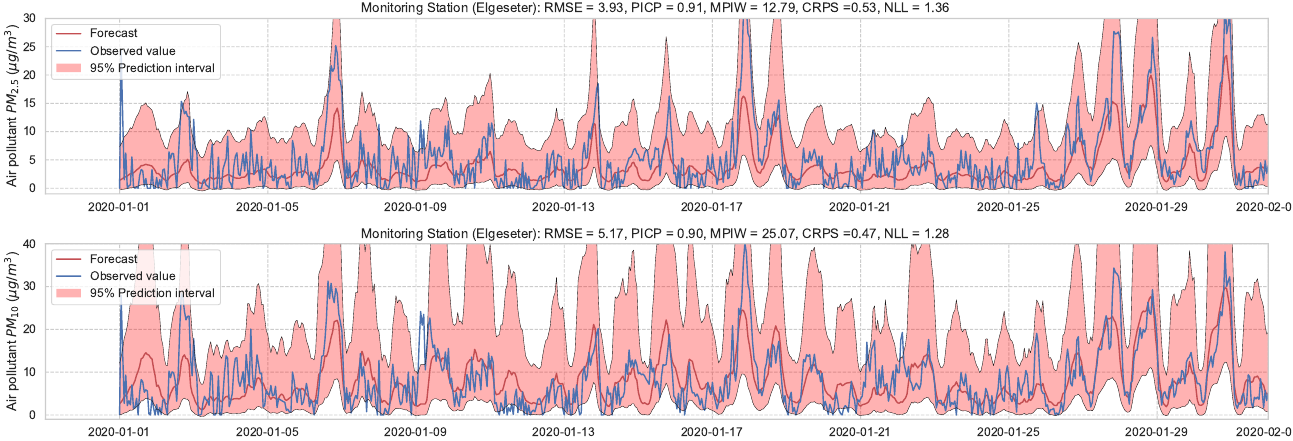
Figure 10. Probabilistic forecasting of multivariate time-series of air quality using a BNN model in one representative monitoring station.